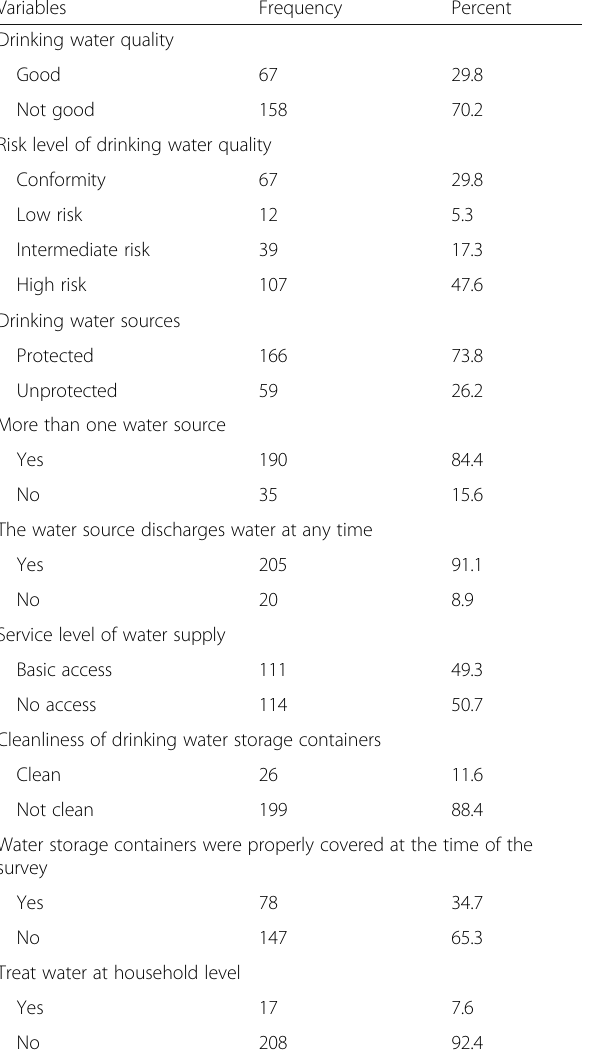
northwest Ethiopia, May 2017 Variables Frequency Drinking water